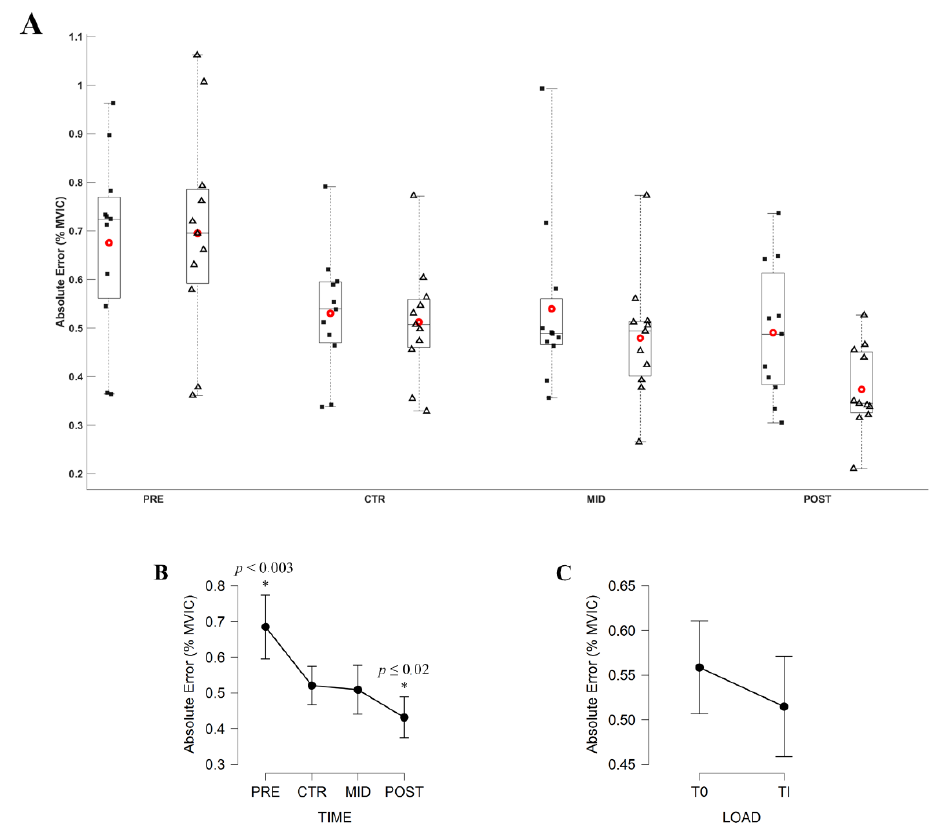
Figure 5. ( A ) Absolute Error (AE; % MVIC) during submaximal contractions computed according to the torque levels, T 0 (black square) and Ti (white triangle), and evaluation sessions (PRE, CTR, MID, POST sessions). Each whiskers box indicates the mean (red circle) and the median (horizontal line). The inferior and superior edges of the box indicate the 25th and 75th percentile, respectively. Black dots represent individual participant performance. ( B ) AE during submaximal contractions computed according to evaluation sessions and ( C ) to the torque levels. Error bars represent the most extreme and non-outlier data points ( A ) and 95% confidence intervals ( B , C ). * significantly different from all other conditions.